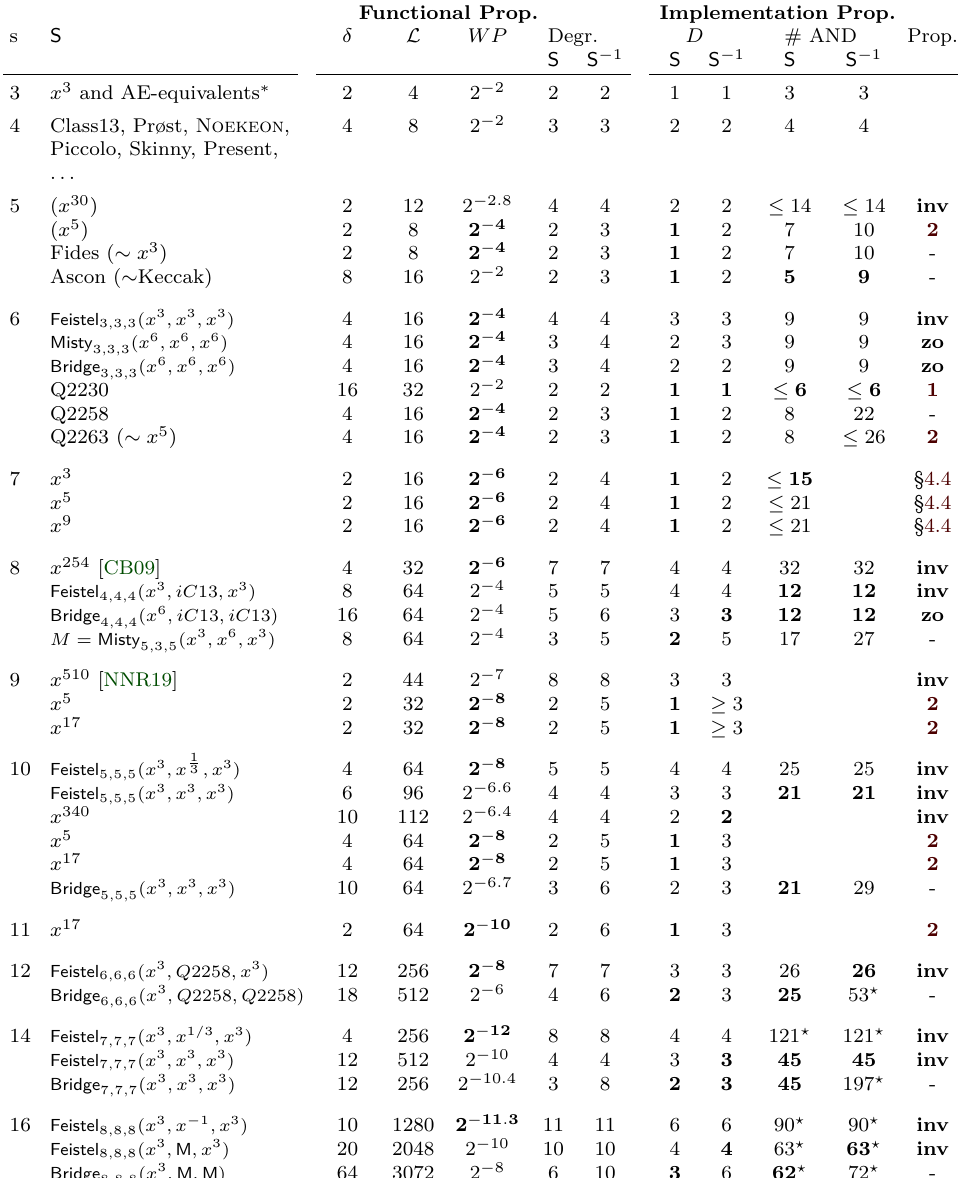
Table 9: Overview of all